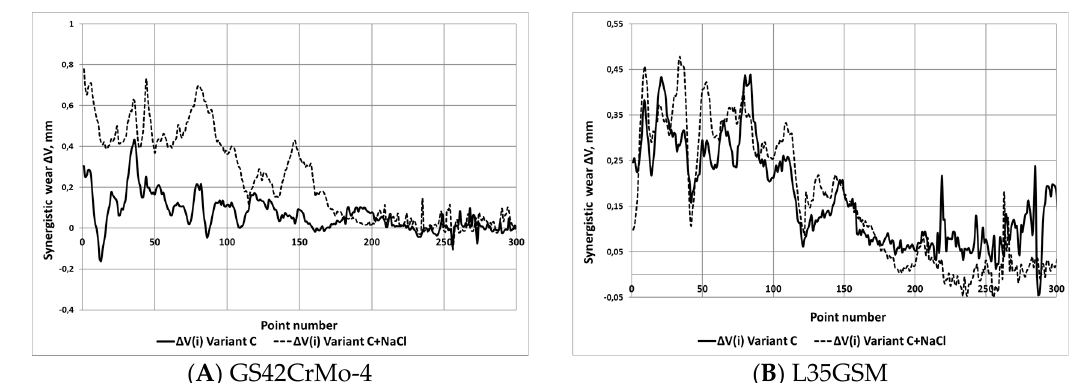
Figure 15. Curves of synergistic component in the function of location on the Δ V(i) measurement path ( A ) Determined for GS42CrMo-4 steel casts, ( B ) Determined for L35GSM steel casts. Figure 16a presents the Δ V component in the function of the maximum strength of the analyzed steels, determined for both combinations of destructive agents: SiO 2 + H 2 O (Variant C) and SiO 2 + H 2 O + 3.5%NaCl (Variant C + NaCl). Figure 16b, in turn, presents the proportion of the component against the abrasive wear value ( Δ V/V M ) of the given steel.